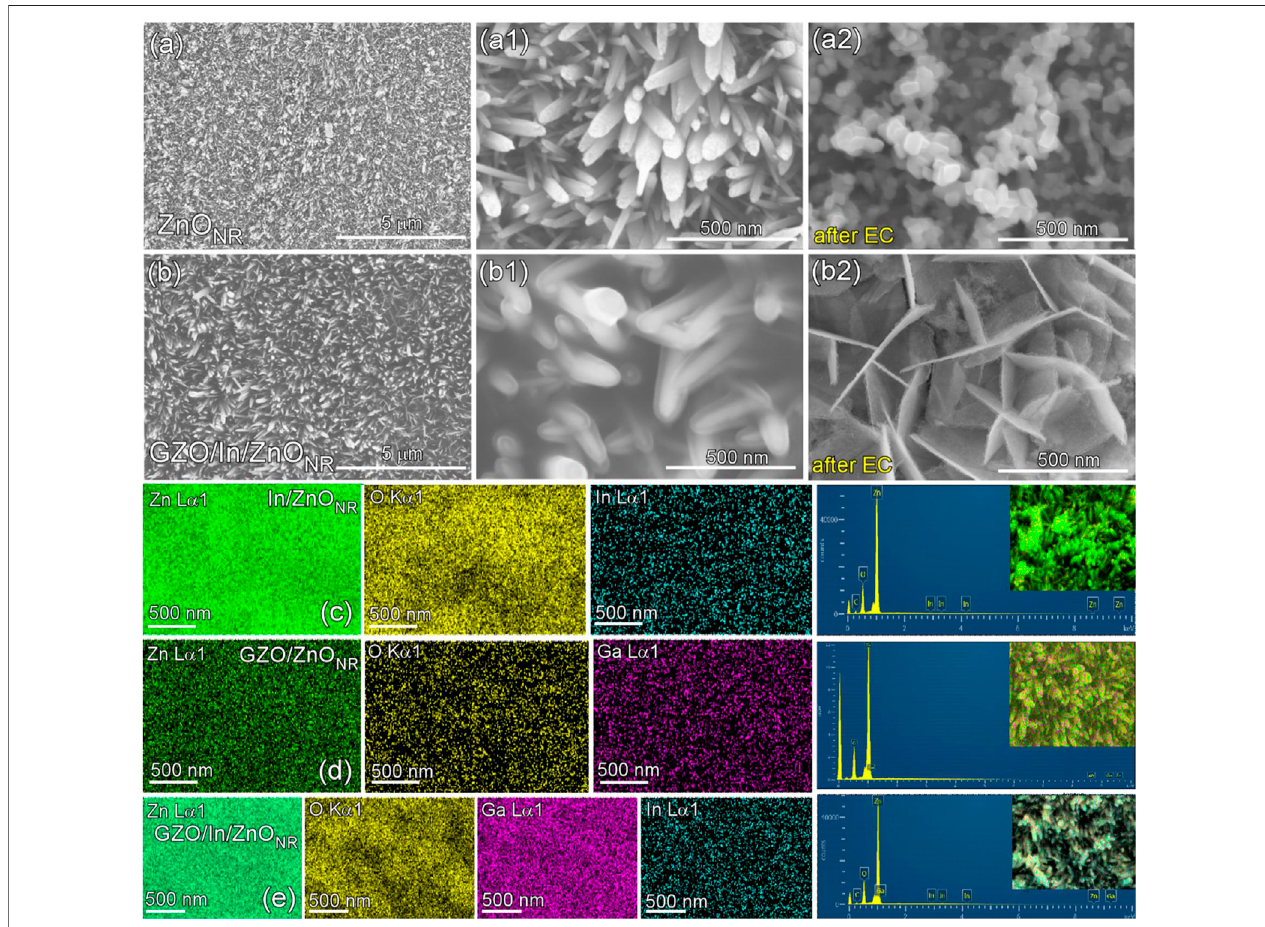
FIGURE 2 | SEM images of bare ZnO NR (A, A1, A2) and GZO(100s)/In(960s)/ZnO NR (B, B1, B2) electrodes before and after electrochemical (EC) tests. EDX elemental mapping images and the corresponding spectra for In(240s)/ZnO NR (C) , GZO(100s)/ZnO NR (D) , and GZO(800s)/In(240s)/ZnO NR (E) samples.